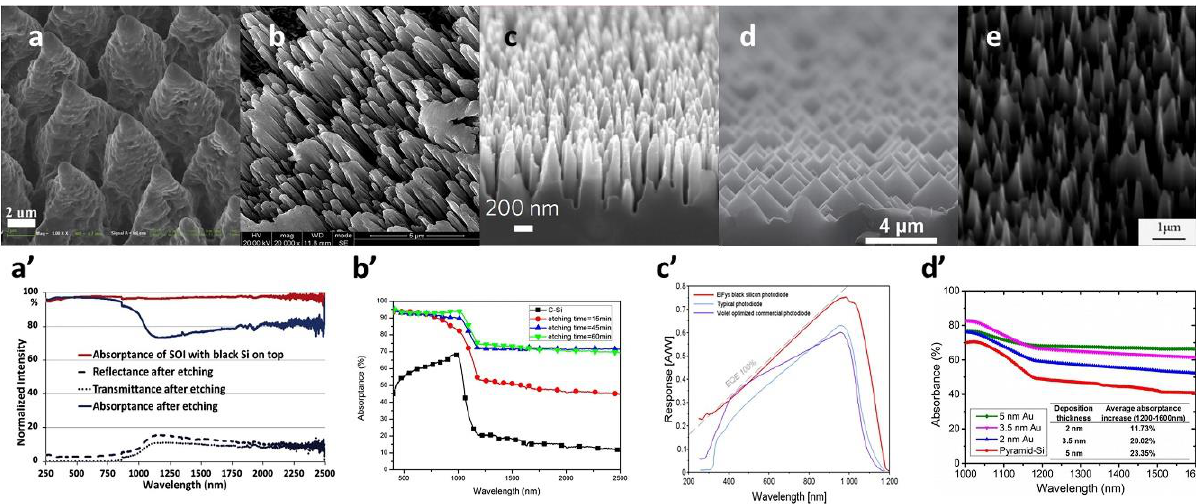
Figure 8. SEM and optical performances of using different fabrication methods. ( a , a’ ) Black silicon using femtosecond/nanosecond laser irradiation. Adapted from reference [37], with permission from Elsevier © 2020. ( b , b’ ) Black silicon using metal assistant chemical etching. Adapted from reference [50], with permission from Springer Nature© 2020. ( c , c’ ) Black silicon using reactive ion etching. ( d , d’ ) Black silicon using wet chemical. Adapted from reference [70]. ( e ) Black silicon using plasma immersion ion implantation etching. Adapted from reference [21], with permission from Elsevier© 2020.